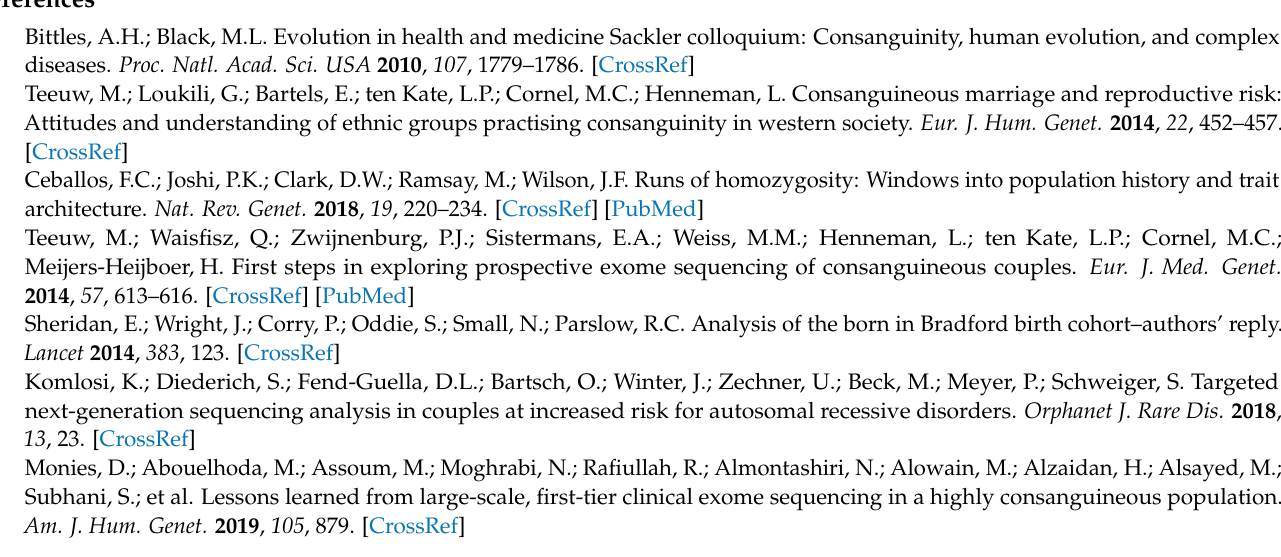
WES data output. Table S2: Rare variants of uncertain significance found in case 2. Table S3: Clinical features and molecular data of patients with a condition related to KATNB1 biallelic variants. Table S4: Clinical features and molecular data of patients with a condition related to FAT1 biallelic